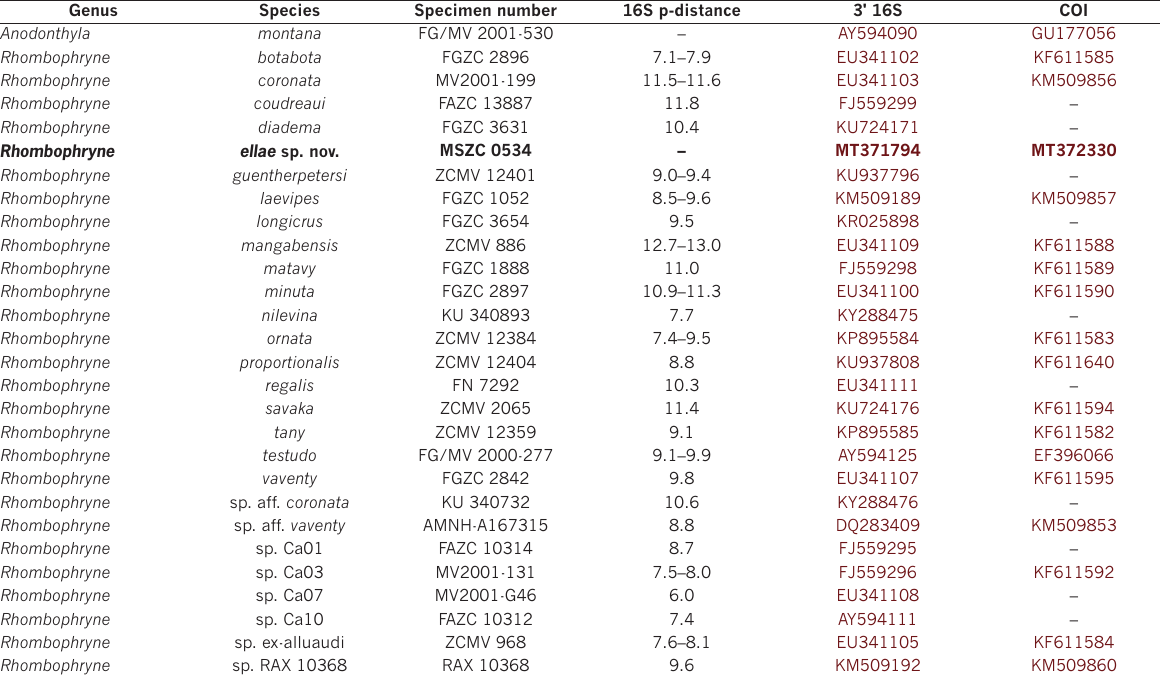
Table 1. Uncorrected pairwise distance (p-distance) in the 3′ fragment of the 16S rRNA mitochondrial marker, and GenBank ac - cession numbers of sequences used to reconstruct phylogenetic relationships within Rhombophryne in Figure 1. For the full p-dis- tance table (all comparisons) see Appendix II, which is based on the more comprehensive sampling of specimens for 16S given in Appendix